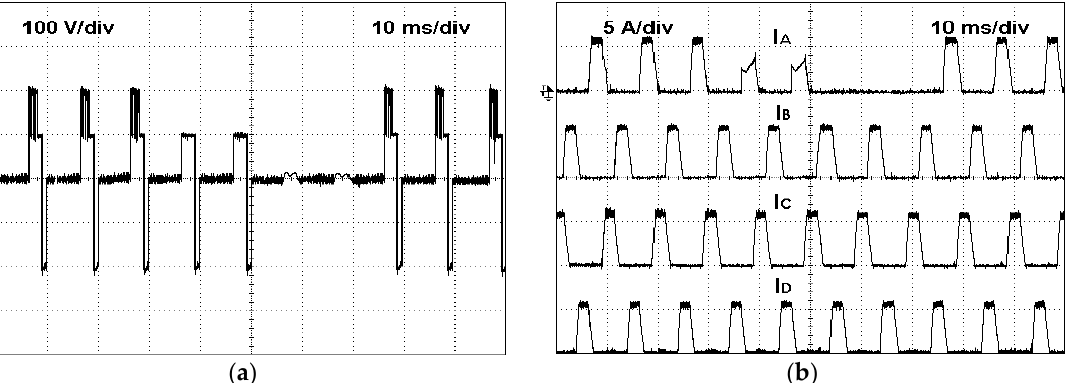
Figure 24. Experimental test with the converter operating in normal mode, then with an open-switch fault ( S 11 ), after that another open-switch fault ( S 21 ) a finally in fault-tolerant mode ( a ) winding voltage of phase A ; ( b ) winding currents.